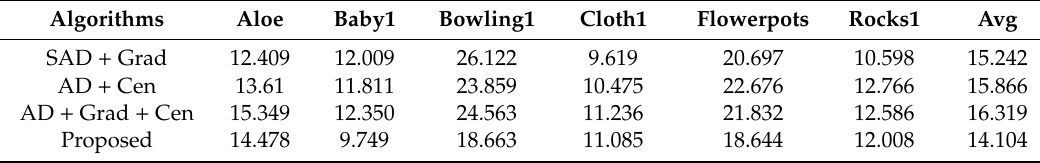
Table 2. Error matching rate of various cost computation under different illumination.